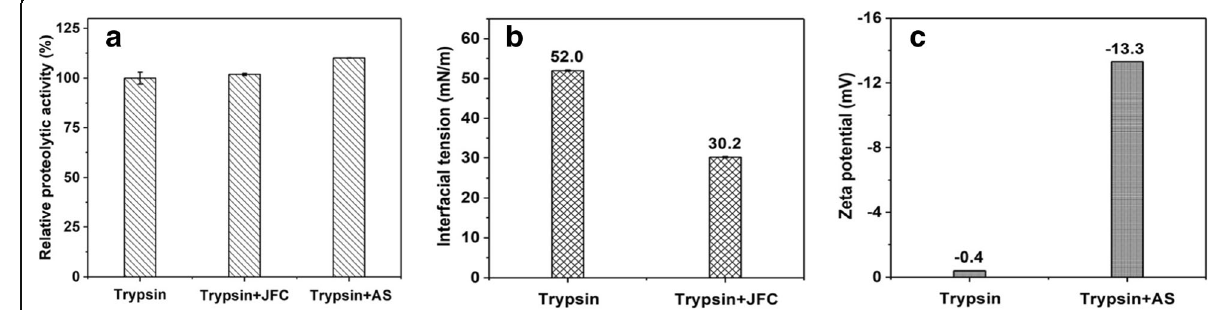
Fig. 7 ( a ) Effects of JFC and AS on proteolytic activity of trypsin; ( b ) effect of JFC on interfacial tension of trypsin solution; ( c ) effect of AS on zeta potential of